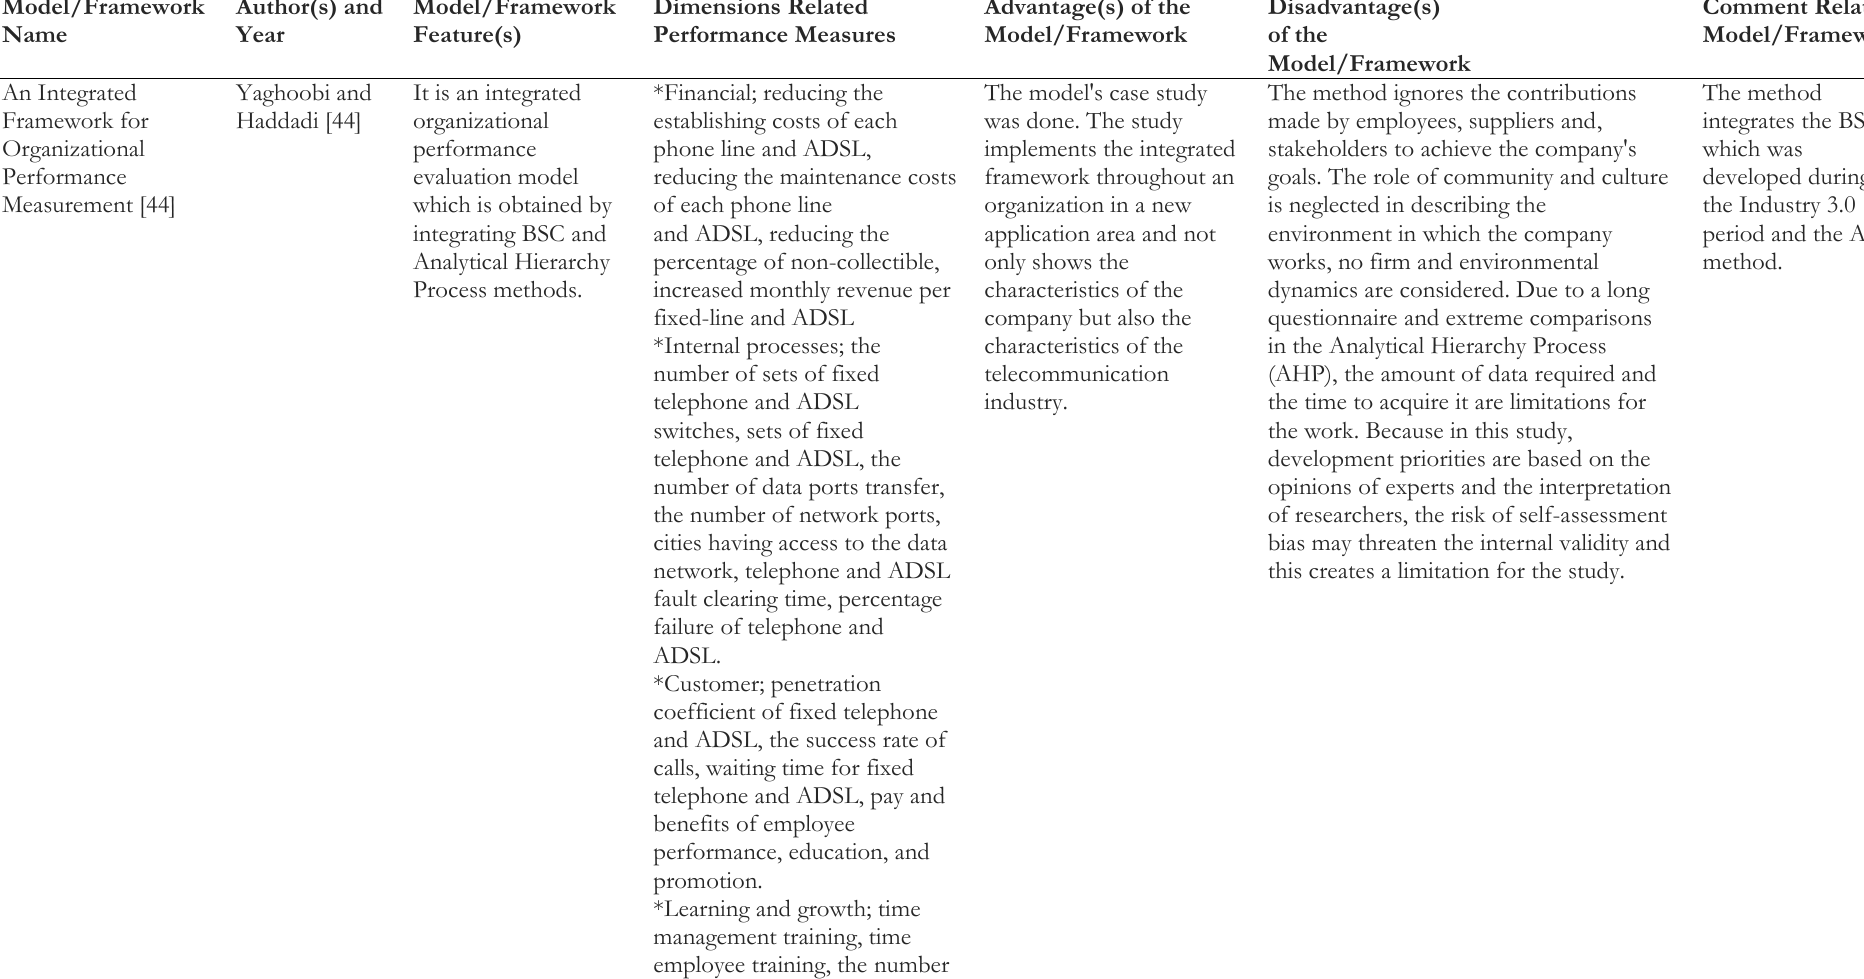
Table 4. Organizational performance measurement models developed in Industry 4.0